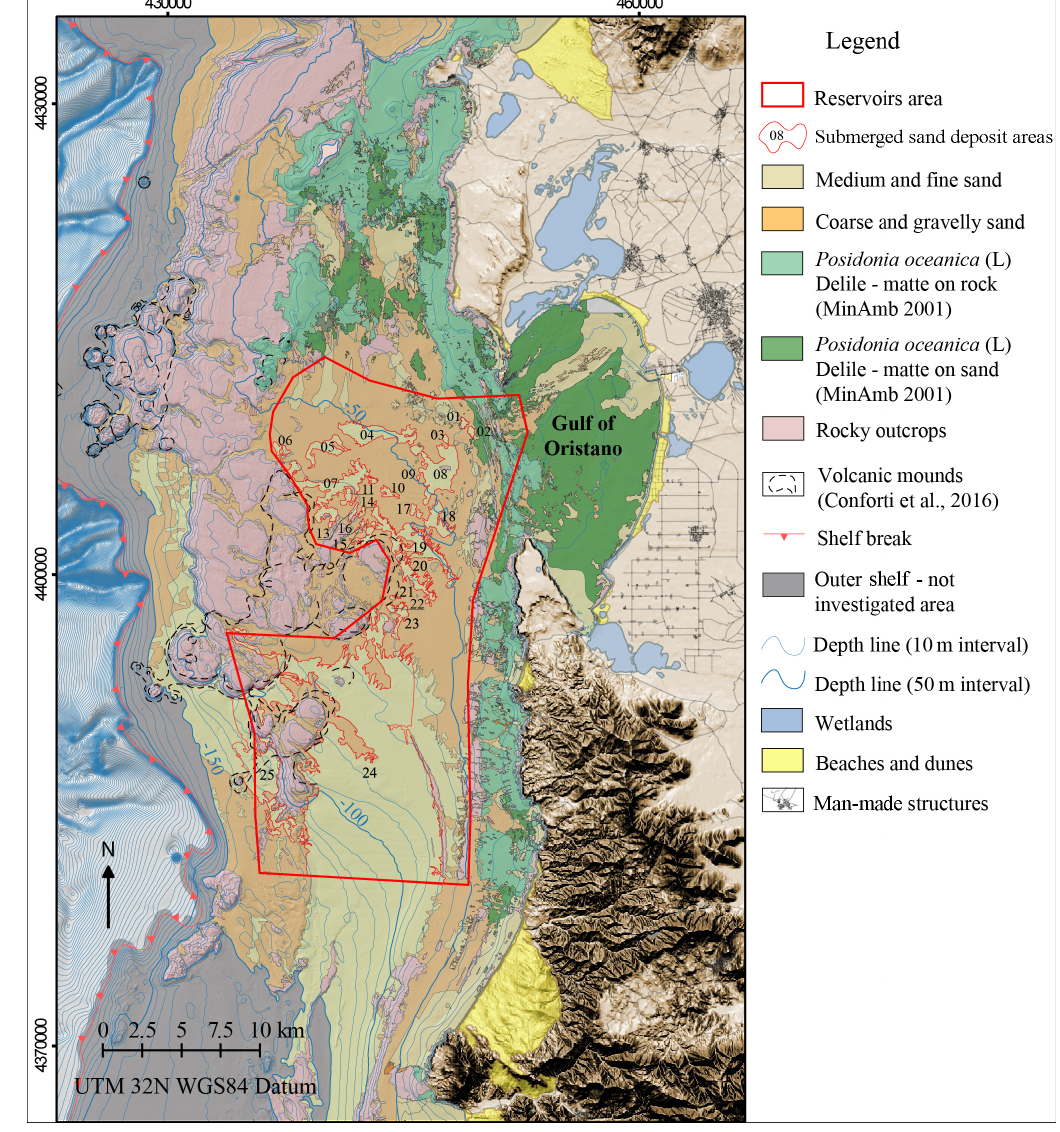
gated. Along this area, several SSDs were detected and char- acterised in terms of grain size, stratigraphy, composition and available